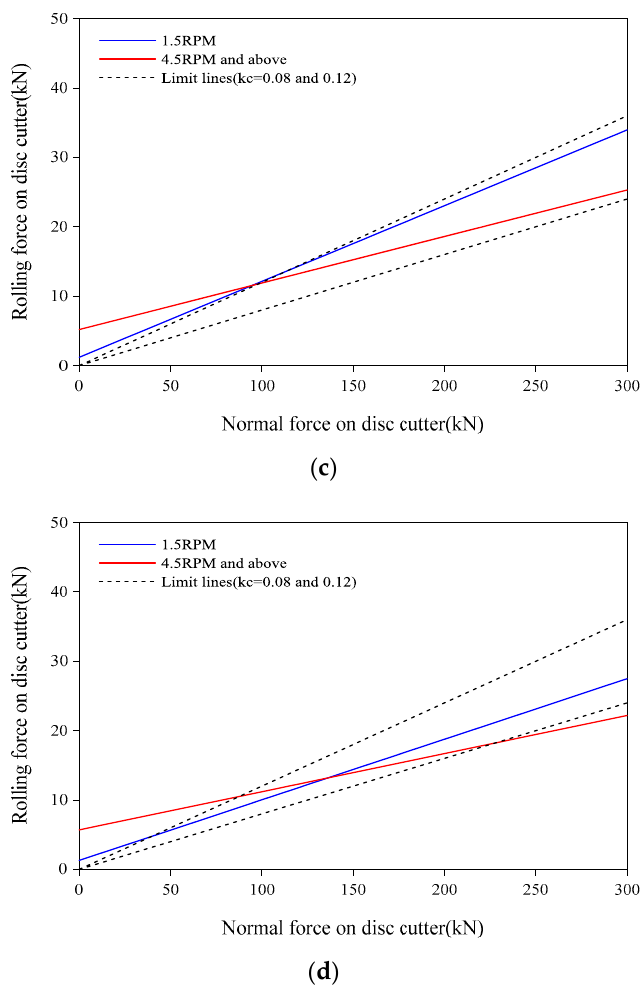
Figure 10. Relationships between normal and rolling force on single disc cutter derived from regression analysis at different UCS levels of artificial rock mass, ( a ) In 20 MPa UCS; ( b ) In 50 MPa UCS; ( c ) In 70 MPa UCS ; ( d ) In 100 MPa UCS.